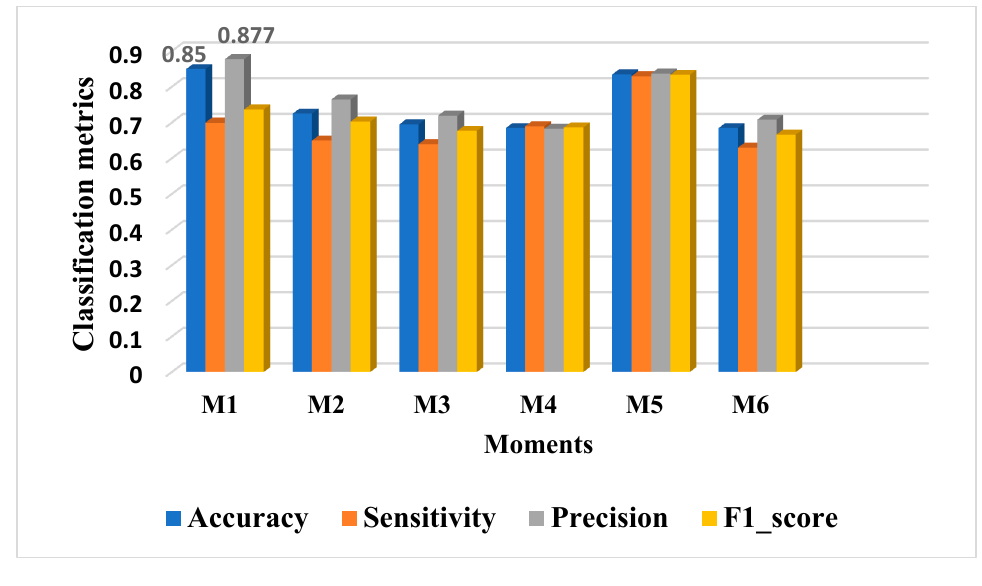
Figure 3. Classification metrics for k-NN.